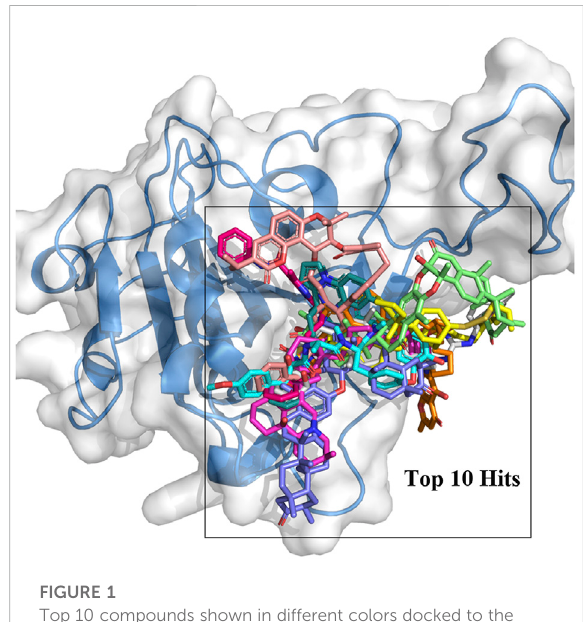
FIGURE 1 Top 10 compounds shown in different colors docked to the RBD PPI interface